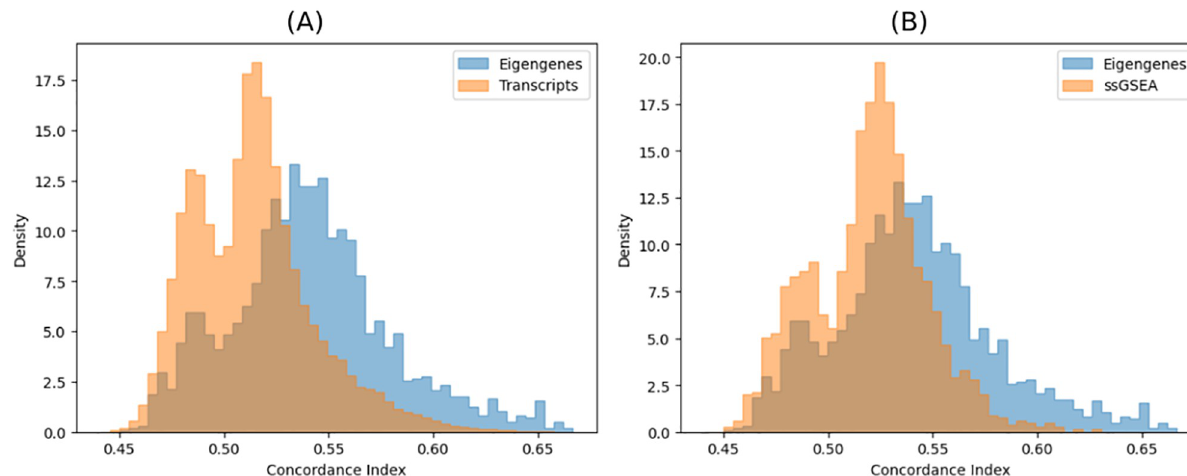
Fig 3. Comparison of how well eigengenes predict survival. A histogram of the concordance indices was calculated with 5-fold cross-validation of Cox regressions based on eigengenes compared to (A) individual transcripts and (B) ssGSEA enrichment scores.